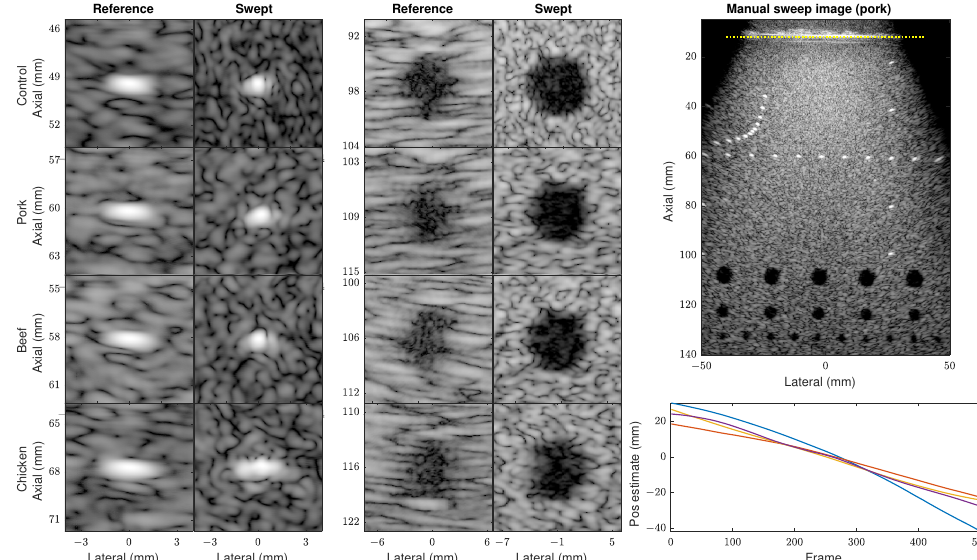
Figure 11. Results of manual sweeps through various tissue phantoms using linear slide fixture. All images show a 50 dB dynamic range. ( Left and middle ) Zoomed images of point and lesion targets from reference (no sweep) and manual sweep data. Spatial axes labels are approximate because position varies slightly between sweeps and targets. ( Right top ) Sample SSA image through pork tissue (12 mm thick, above the dotted yellow line). ( Right bottom ) Estimated positions for each case using channel estimation